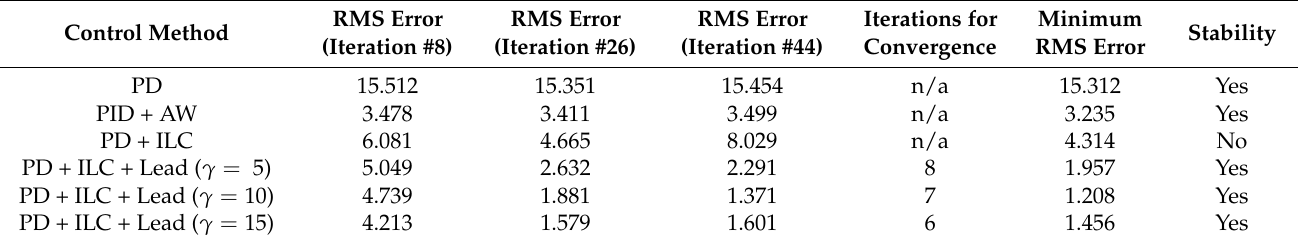
Table 2. Comparison of the RMS tracking error (unit: deg)using different control